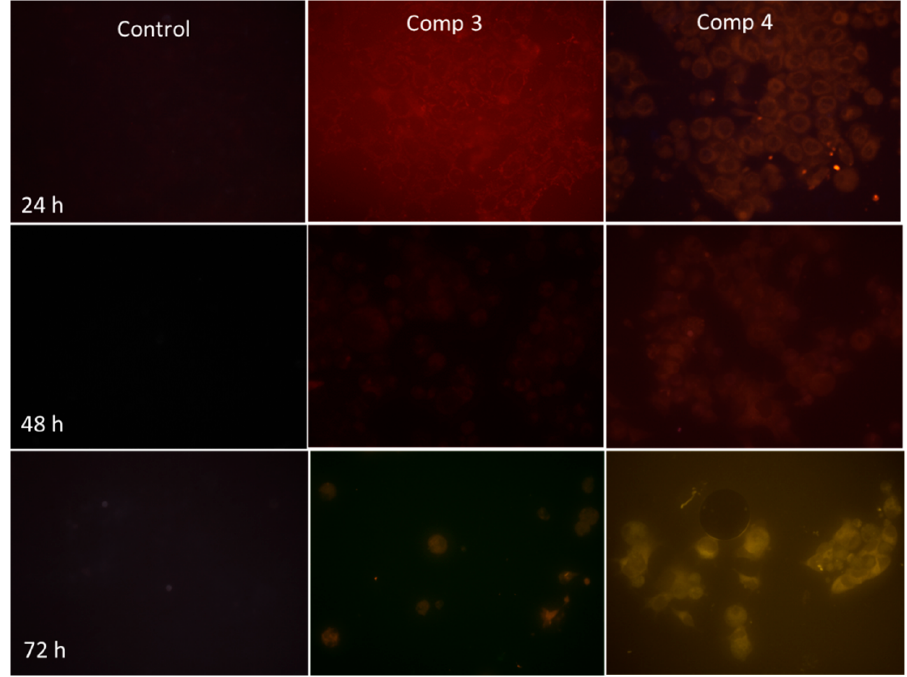
Figure 13. Red-yellow fluorescence of compounds 3 and 4 observed in the MCF-7 cells. Cells were incubated with pyridine-thiazole derivatives at the concentration of 5 µM for 24, 48, and 72 h. Magnification ×400.